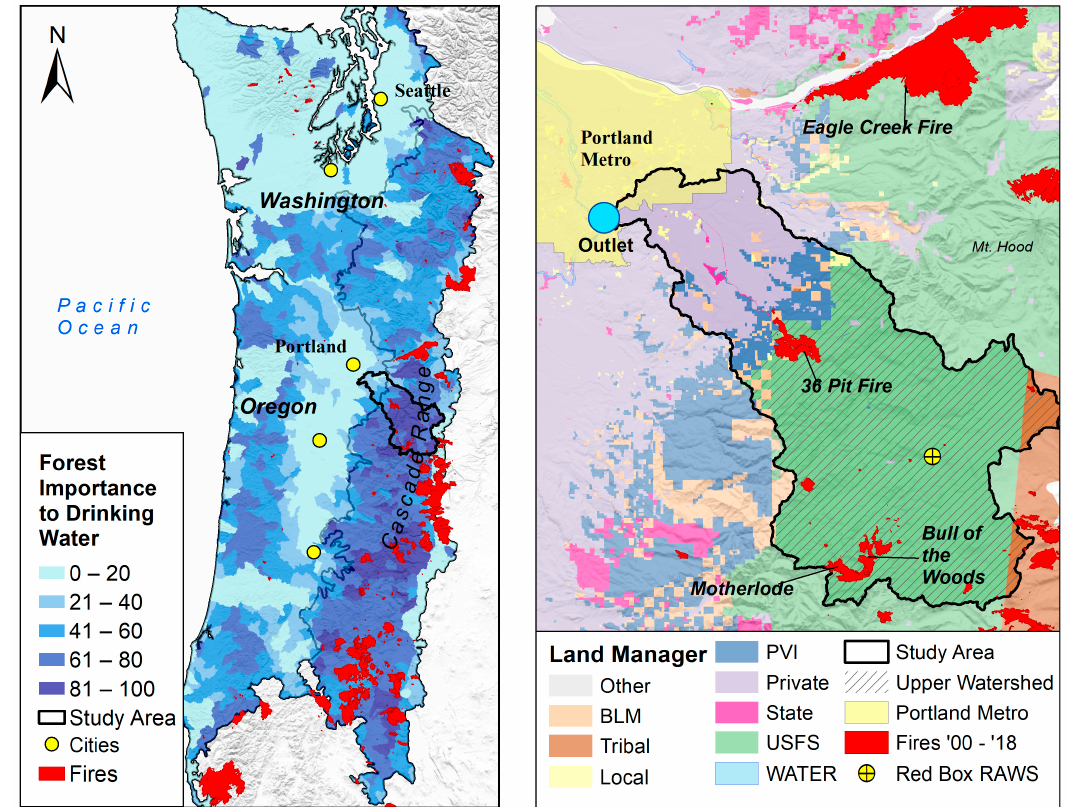
Figure 1. The westside region of Oregon and Washington shown on the left for context of the Clackamas Basin on the right. U.S. Forest Service “Forest to Faucets” [66,67] compares the importance of forests to surface drinking water on a relative scale of 0–100. Forests are especially important to drinking water in westside landscapes ( left ), many of which have experienced few to no significant wildfires in the past 20 years [27]. Prior to 2020, the largest wildfire in recent history in the Clackamas Basin ( right ) was the 36 Pit fire in 2014 which burned just over 2200 ha on the Mt. Hood National Forest, but adjacent to private land